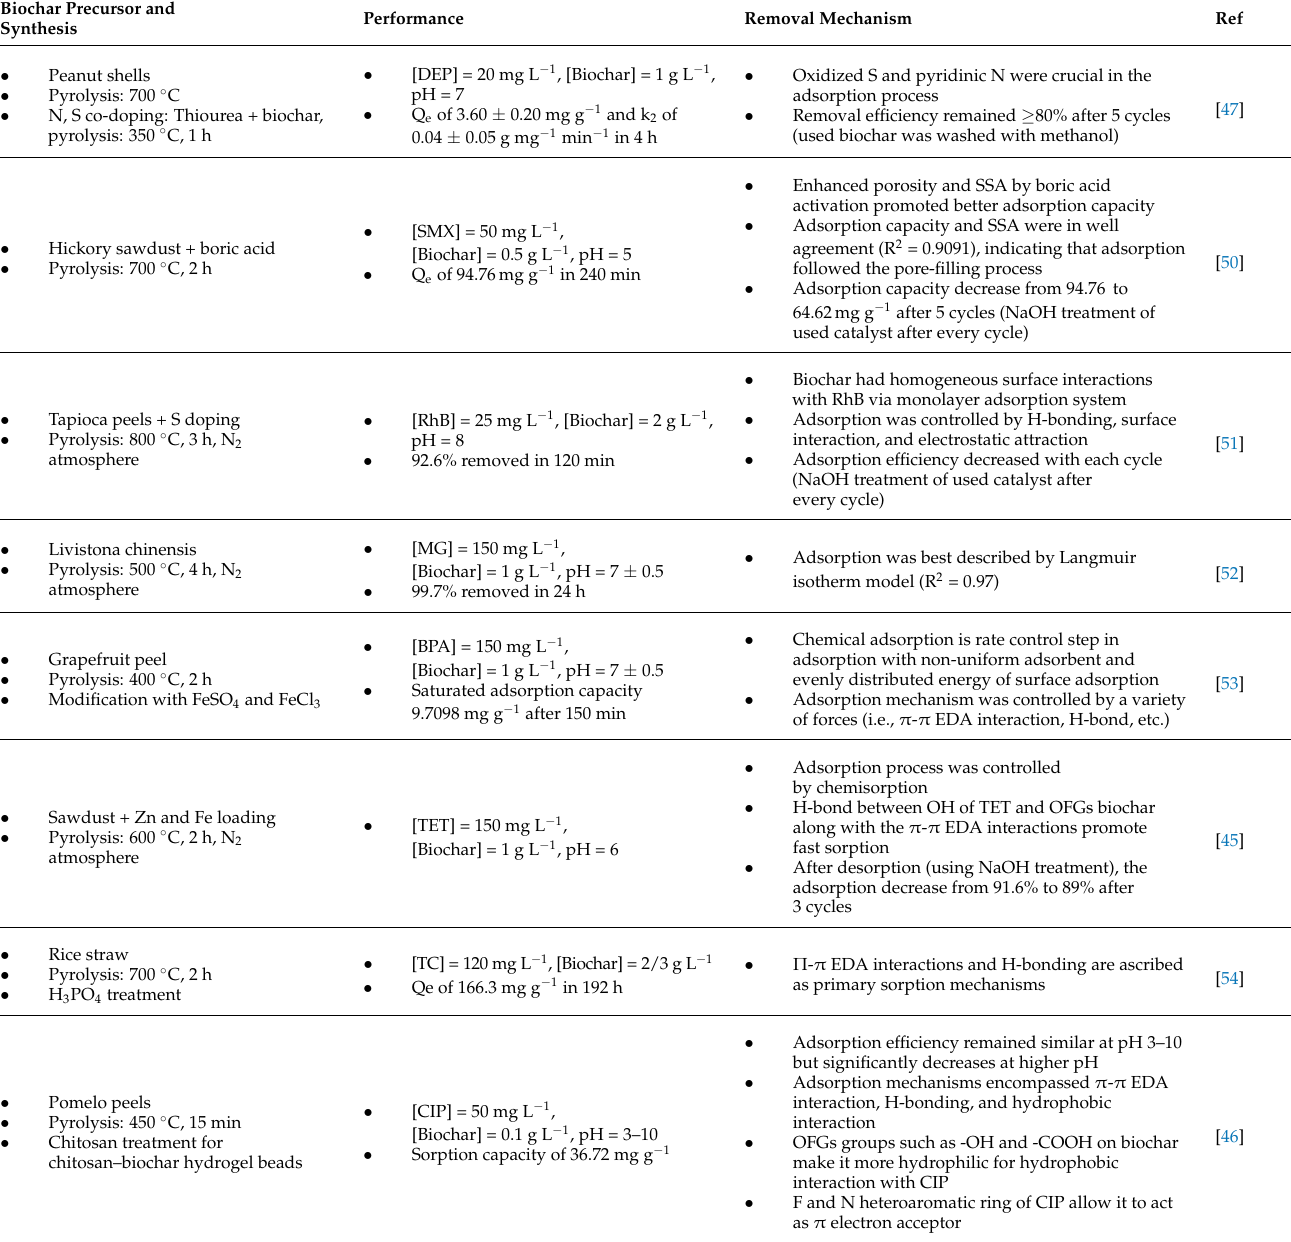
Table 1. An overview of biochar preparation and performance in adsorption of organic